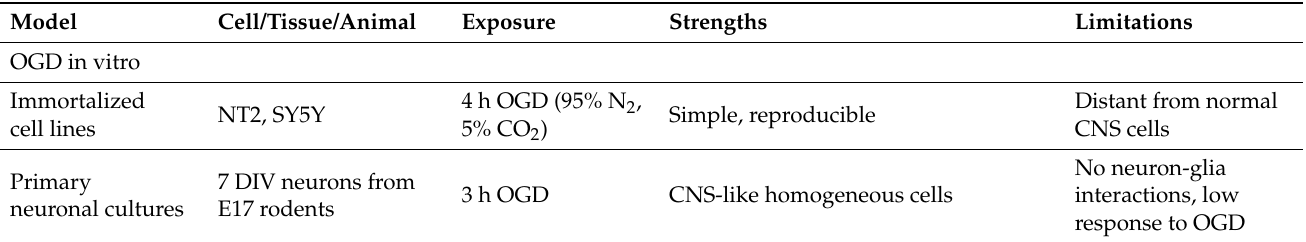
Table 1. Strengths and limitations of the principal in vitro and in vivo models of neonatal HIE.